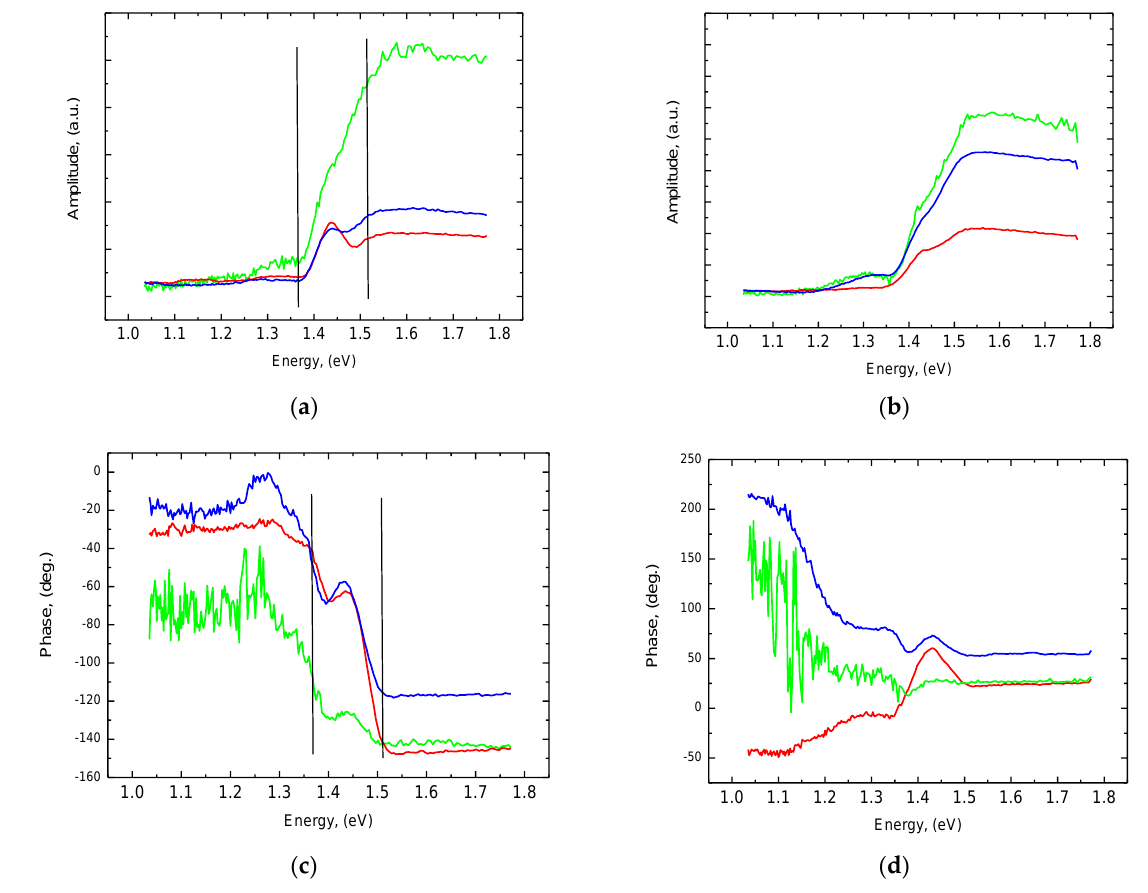
Figure 3. Amplitude ( a , b ) and phase ( c , d ) spectra for Cd 0.99 Be 0.01 Te grounded mixed crystal for different frequencies of modulation frequency for the rear ( a , c ) and front ( b , d ) configurations at 12 Hz (blue lines), 76 Hz (green lines), and 126 Hz (red lines). The different amplitude and phase spectra characters were observed for the Cd 0.9 Be 0.1 Te mixed crystal. Figure 4 presents amplitude (a) and phase (b) spectra for this sample.